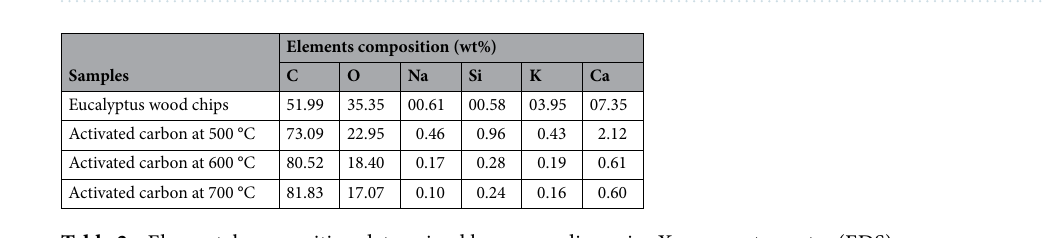
Table 2. Elemental composition determined by energy dispersive X-ray spectrometer (EDS).